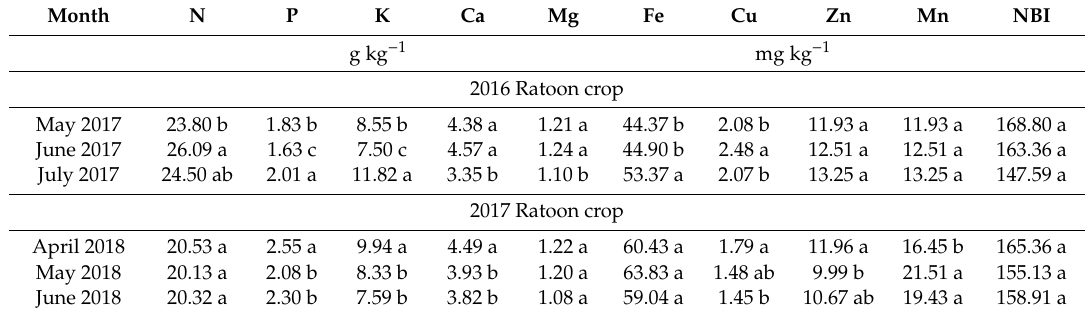
Table6. LeastSquaremeansforseasonalleaftissuenutrientconcentrationsofmacroandmicro-nutrients and nutrient balance index (NBI) in sugarcane ratoon